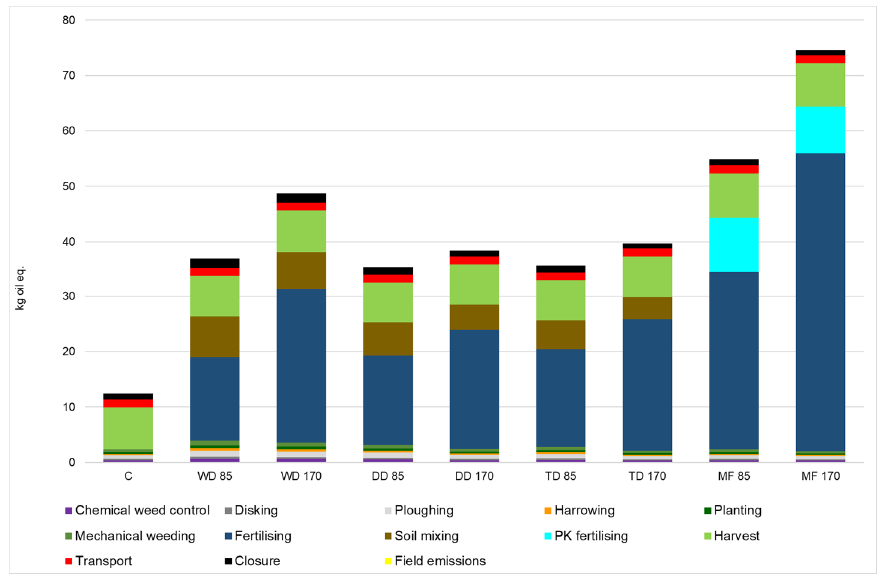
Figure 10. Fossil depletion per 1 Mg d.m. of miscanthus in different fertilisation treatments.